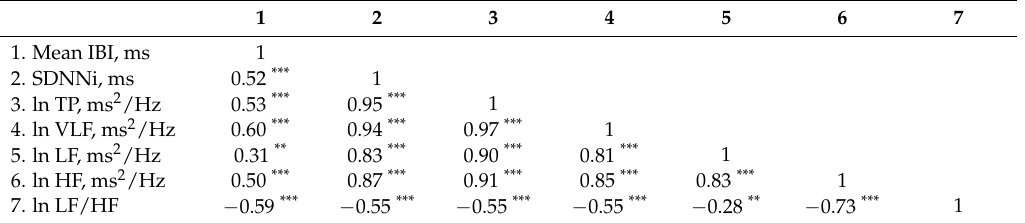
Table 2. HRV Measures—Correlation Coefficients.